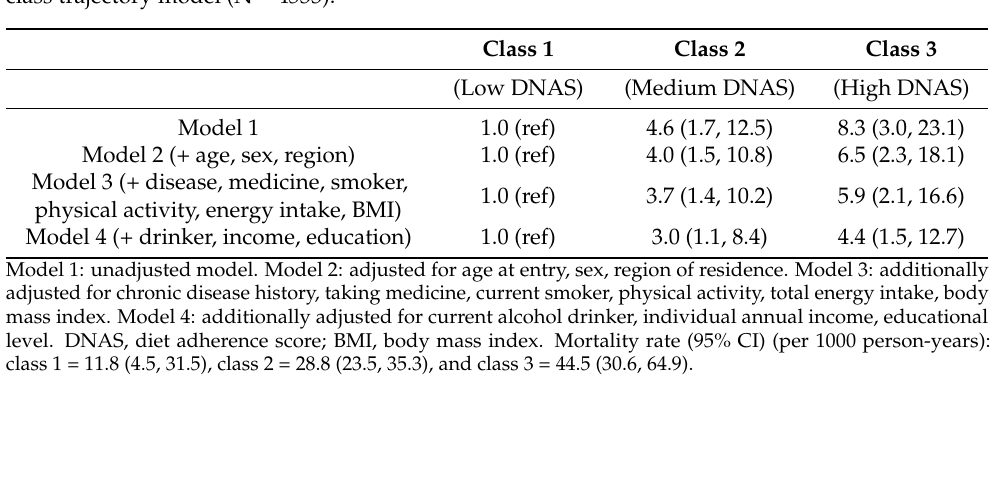
Table 2. Hazard Ratios (95% Confidence Interval) of all-cause mortality for classes identified by latent class trajectory model (N =